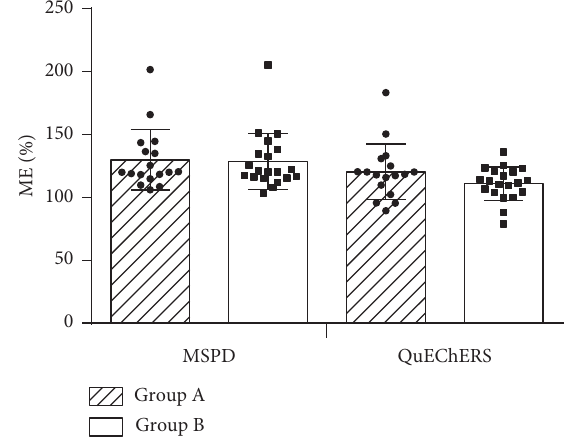
Figure 6: Matrix effects of different pretreatment